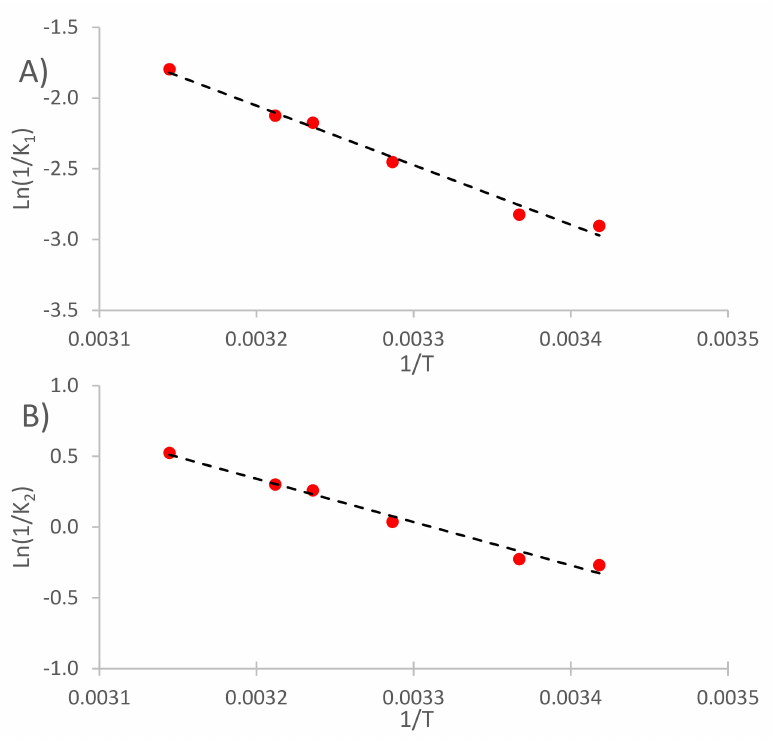
Figure 4. Arrhenius plots of the six non-sonicated extractions at different temperatures (NUS), ( A ) K 1 constant and ( B ) K 2